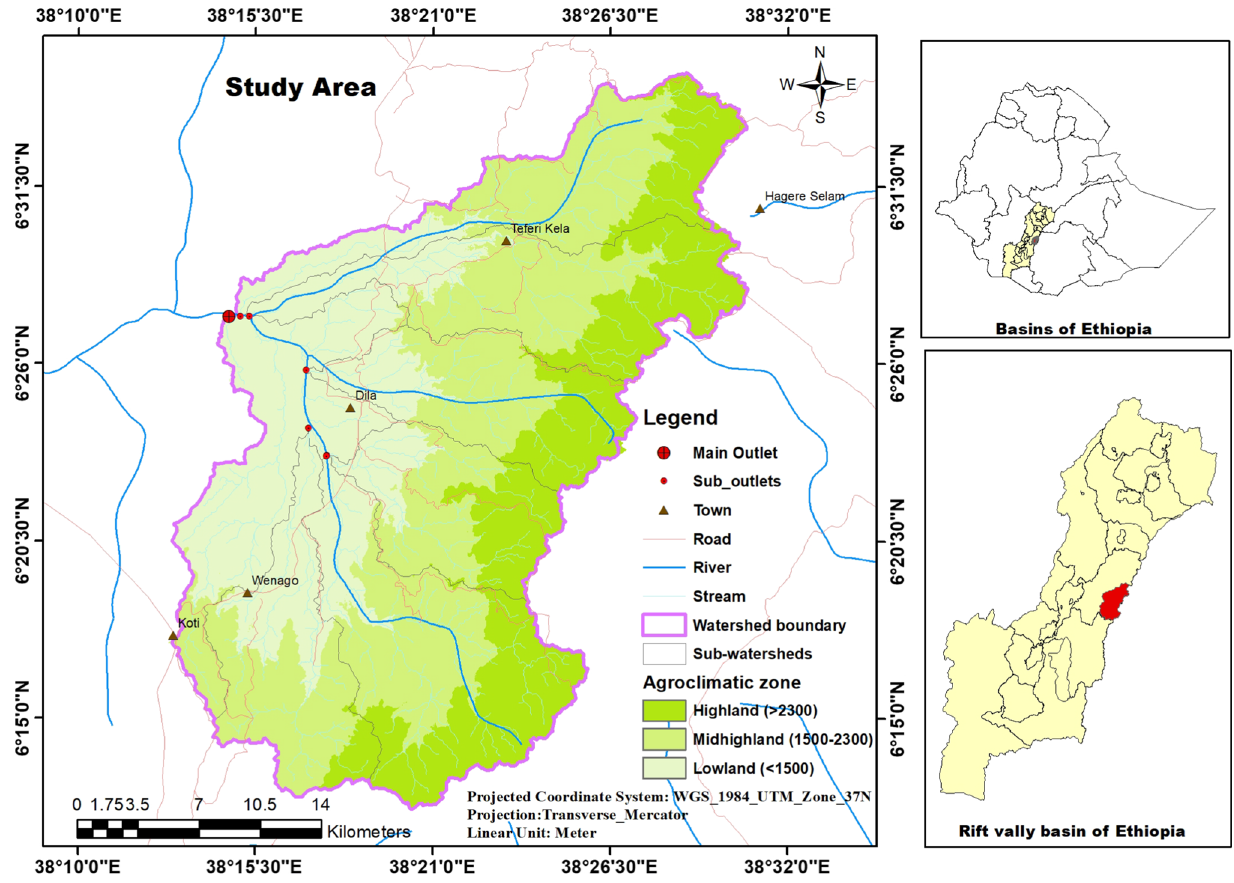
Fig. 1 Location map of the study area. ( Source :